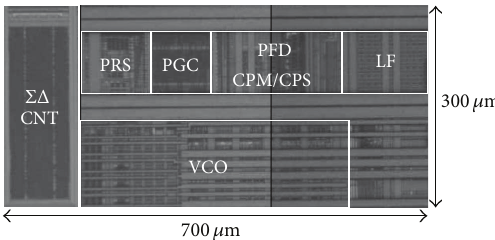
Figure 26: Test chip